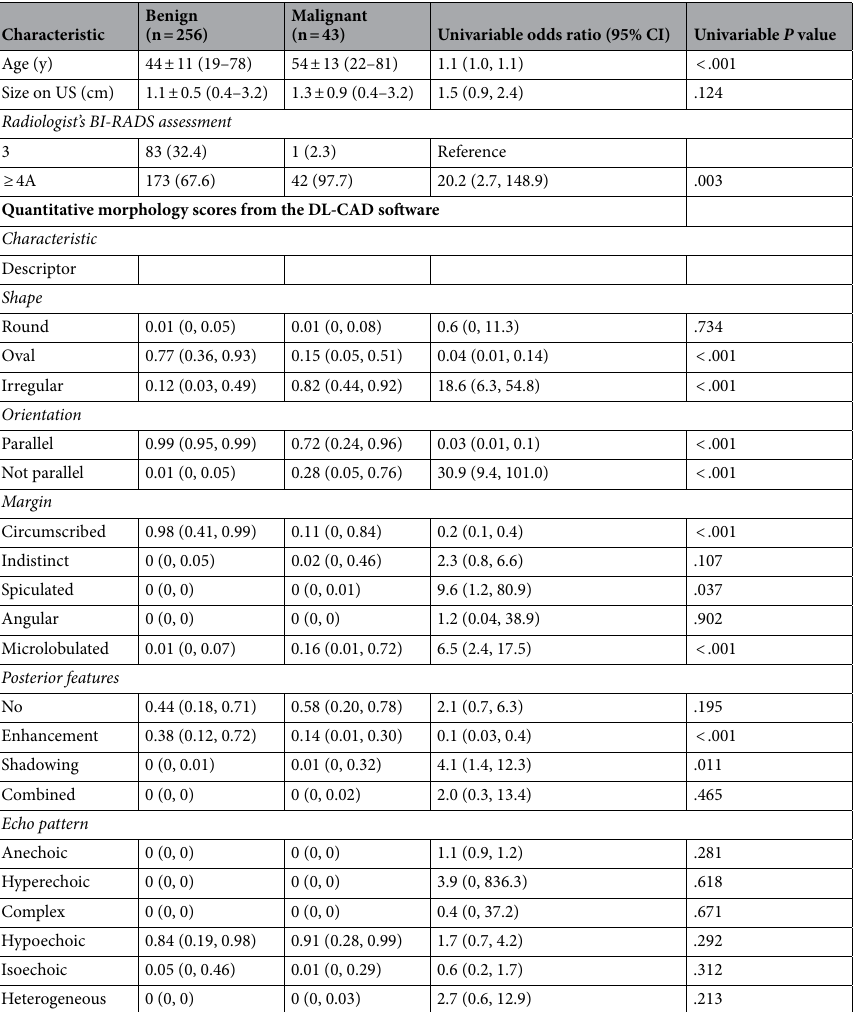
Table 2. Characteristics of the benign and malignant breast lesions in the development cohort. BI-RADS, Breast Imaging Reporting and Data System, CI, confidence interval, DL-CAD, deep learning-based computer- aided diagnosis. Data for the age and size are expressed in terms of the mean ± standard deviation (ranges). Data for the BI-RADS final assessment are presented as numbers (percentages). Data for quantitative morphologic scores from the DL-CAD software are presented as median (25th percentile, 75th